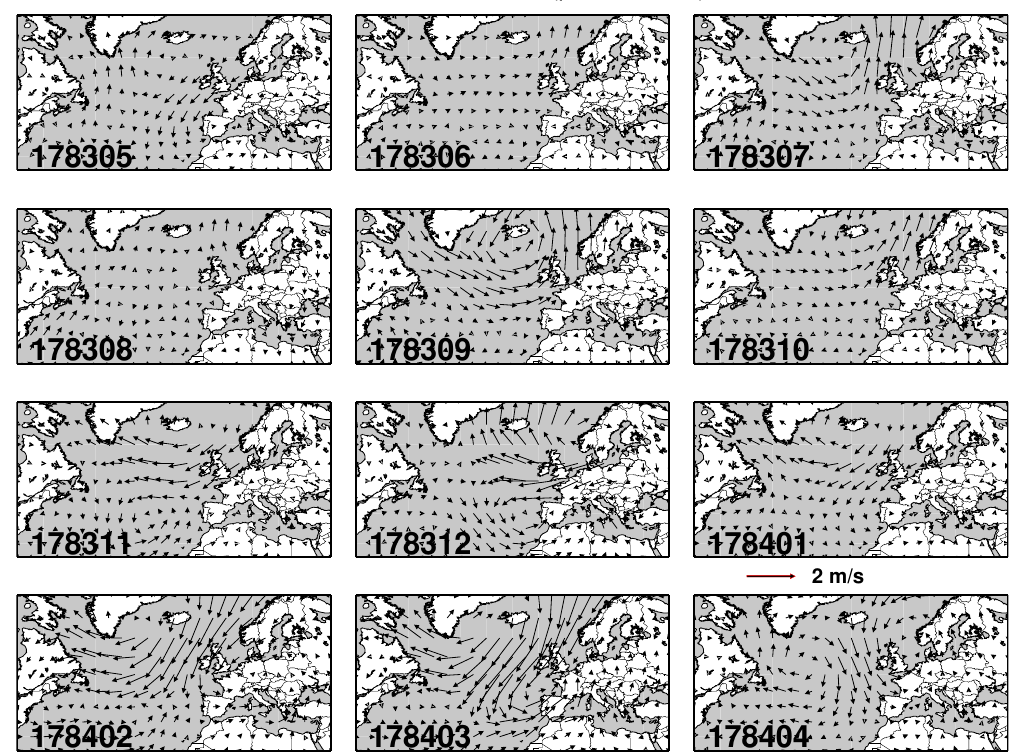
Fig. 7. Anomalies of wind speed at 1000hPa between May 1783 and April 1784. The red horizontal arrow indicates the wind speed scale (in ms − 1